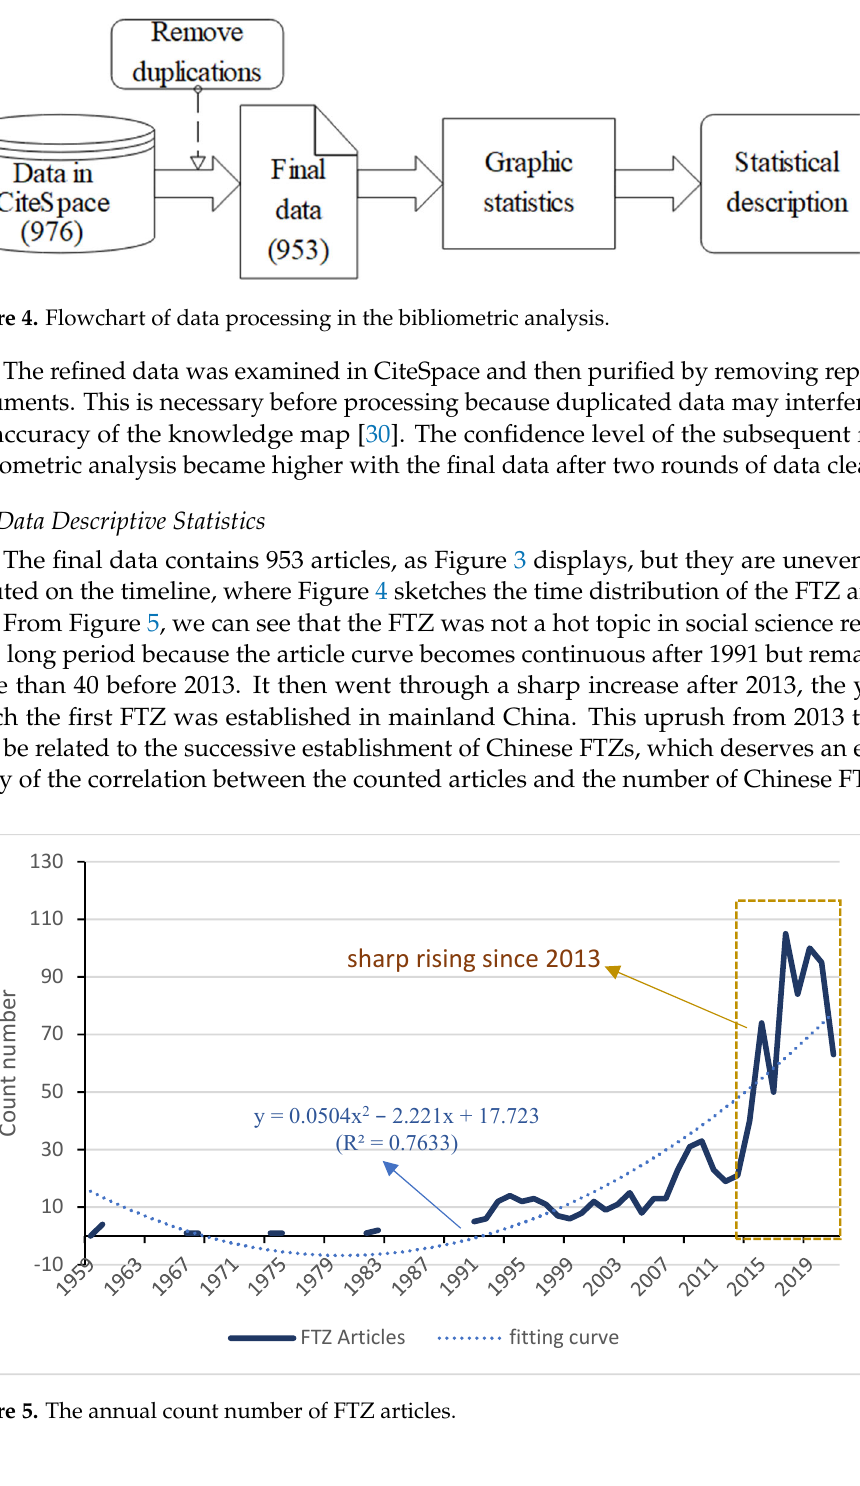
6 of 23 Figure 3. Flowchart of data acquisition before the bibliometric analysis.